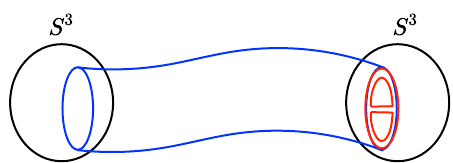
Figure 19 . Annihilation of the probe branes gives rise to the partition function Z deformed ( t, t 0 ) , which describes world worldsheet instantons stretched between D branes on the two S 3 ’s. The quantum dimensions which lead to the q-deformation of the edge modes arise from the ribbon diagrams (red) interacting with the boundary of the instanton worldsheets. We have shown one term in the ribbon diagram expansion corresponding to the “theta”